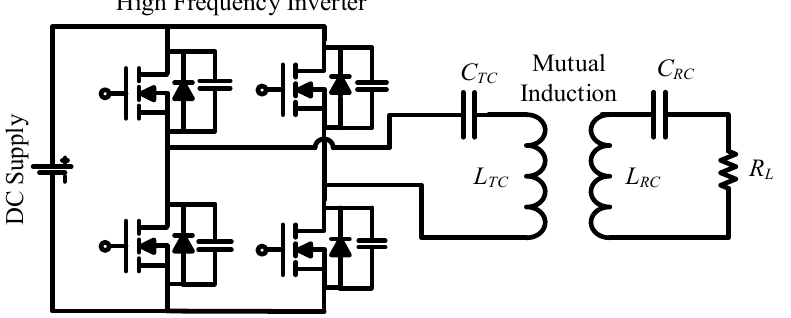
Figure 6. Schematic circuit diagram of experimental inductive power transfer (IPT) system.